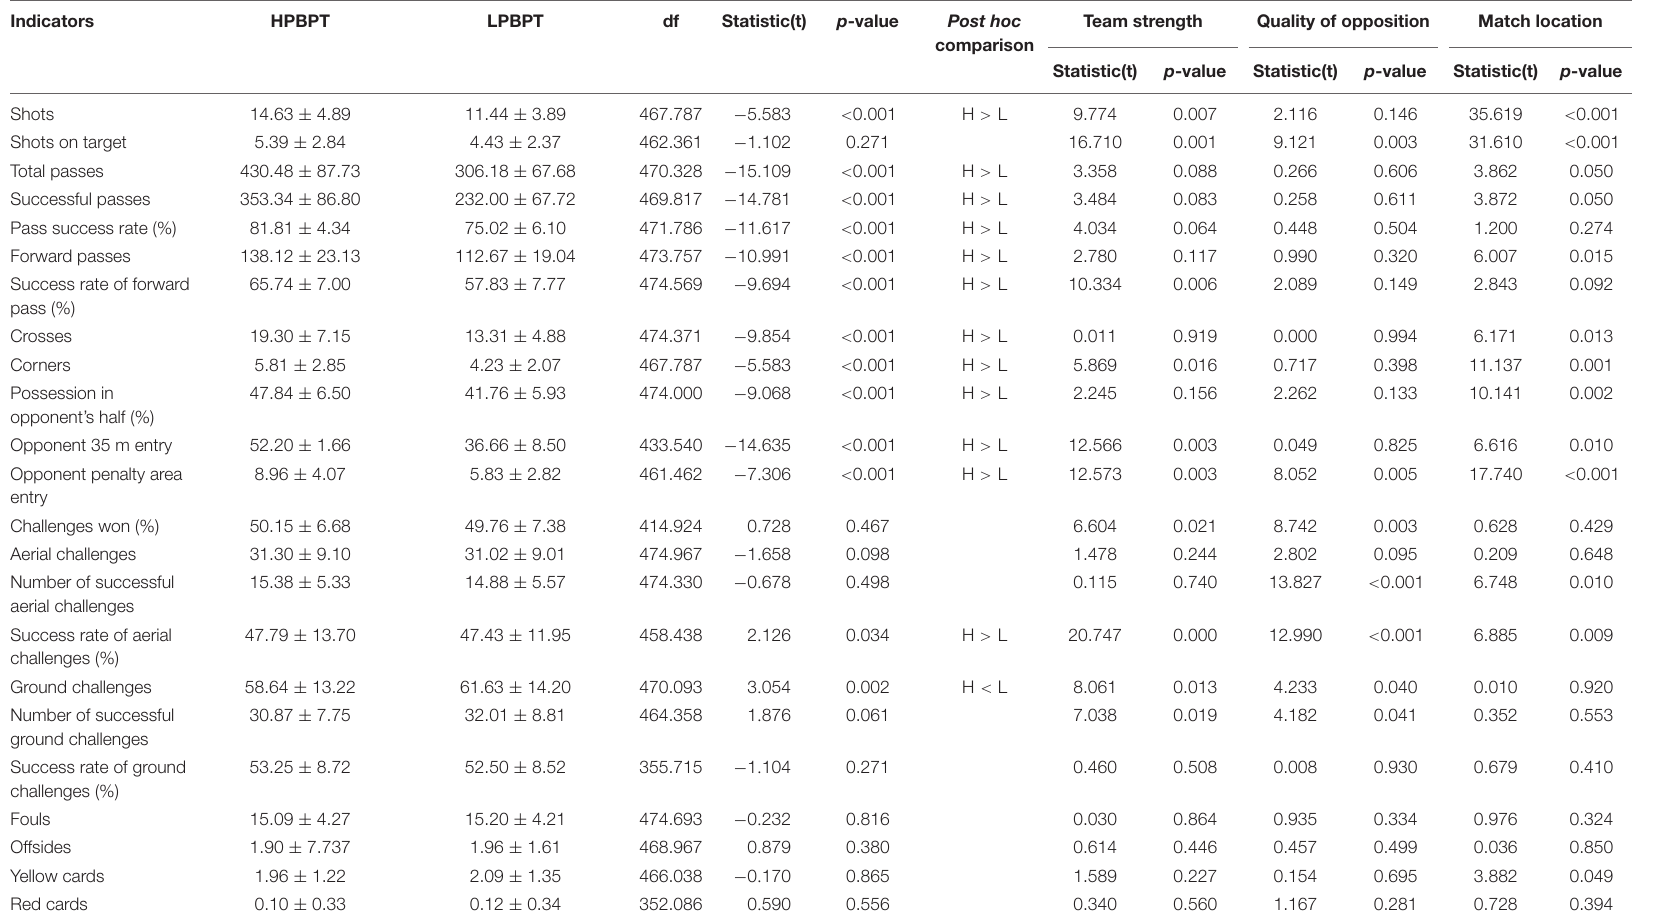
TABLE 4 | Difference of technical performance between HPBPT and